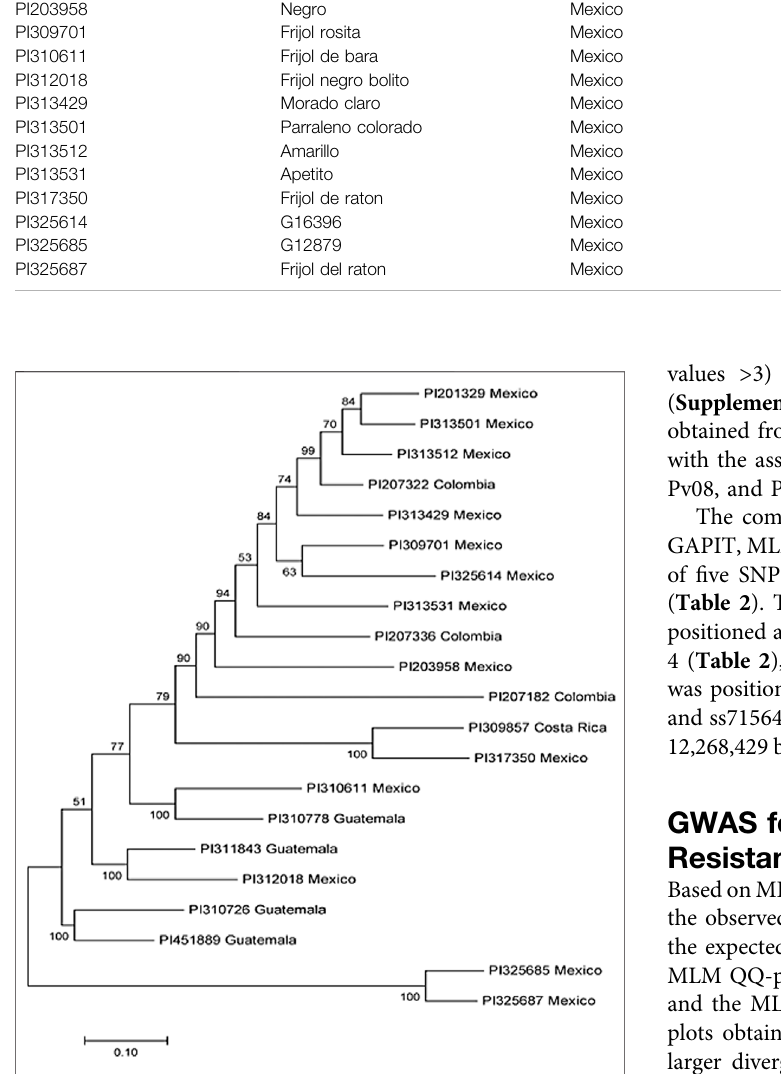
FIGURE 3 | Phylogenetic tree among 21 common bean accessions of bacterial wilt resistance drawn using Mega 7. In the tree, the taxon name consists of the accession ID and the accession original